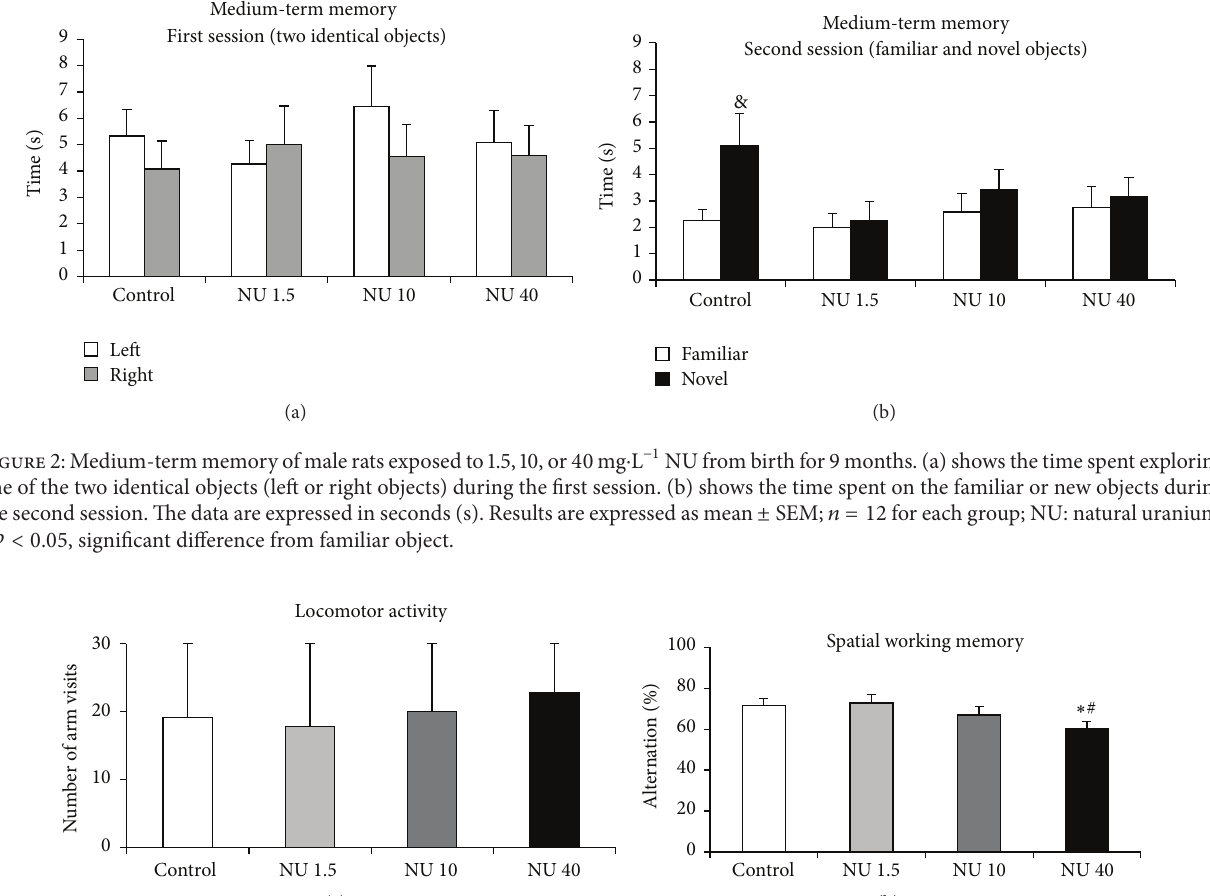
the number of closed arm entries in the elevated plus